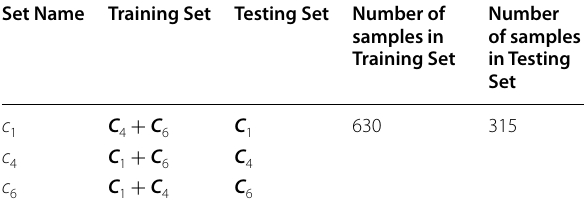
Table 1 Details of the three dataset